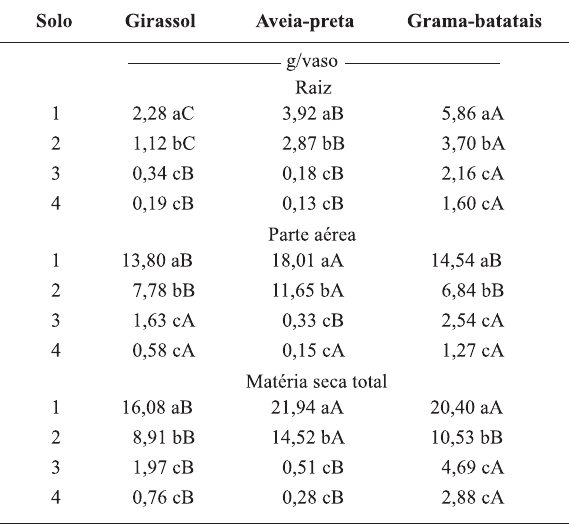
As concentrações de Cr e Ni foram baixas nas raízes, refletindo os baixos teores nos solos (Quadro